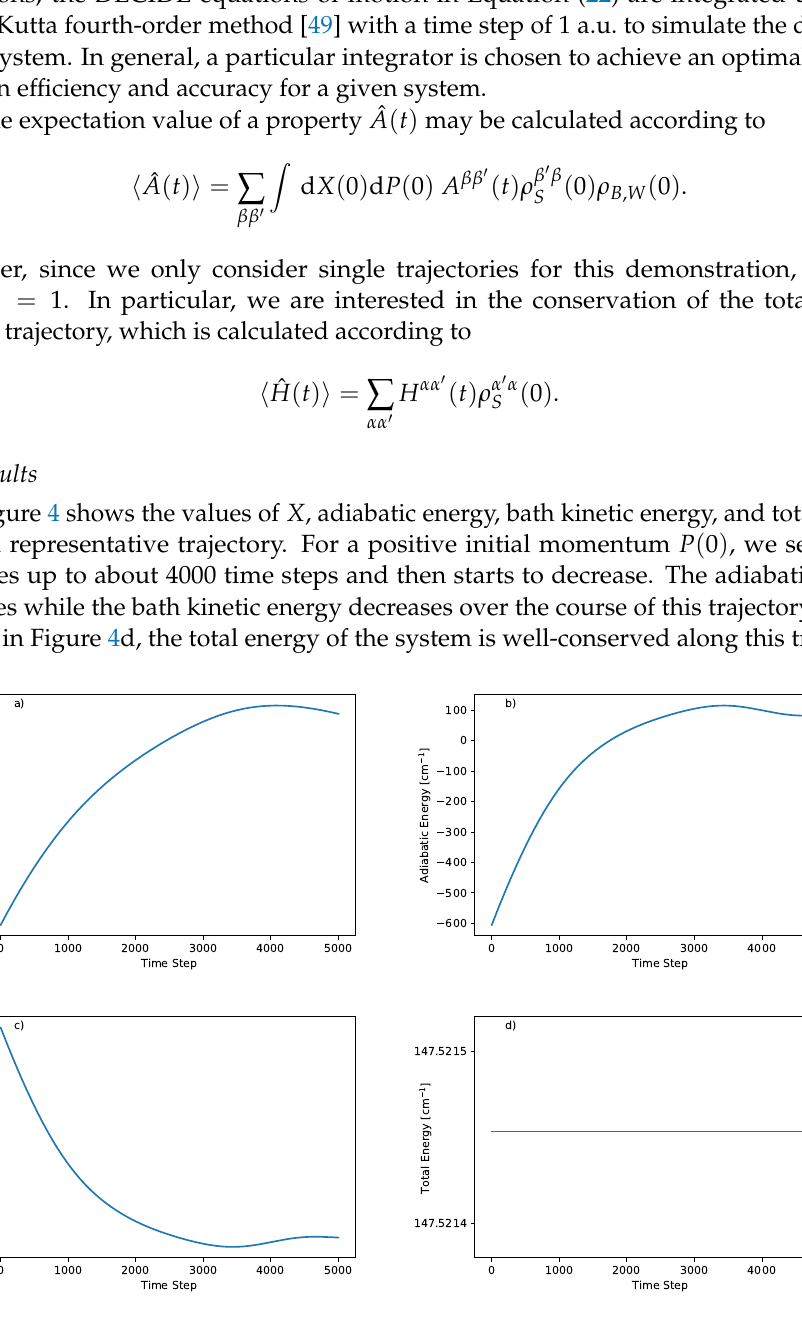
Figure 4. Results for the 1D quadratic proton transfer model obtained with a time step of 1 a.u. and the following parameter values: A 0 = 3367.6 cm − 1 Å − 2 , k 1 = 1.7 × 10 4 cm − 1 Å − 2 , m = 1 amu, M = 200 amu, X ( 0 ) = − 0.2 Å, and P ( 0 ) = 50 au. ( a ) Bath position, X ( t ) , ( b ) Adiabatic energy, (cid:104) ˆ p 2 + A 0 ˆ x 2 + 1 k 1 X ˆ x + 1 k 1 ˆ xX (cid:105) , ( c ) Bath kinetic energy, P 2 , ( d ) Total system energy, (cid:104) ˆ H (cid:105) ( t ) 2 m 2 2 2 M